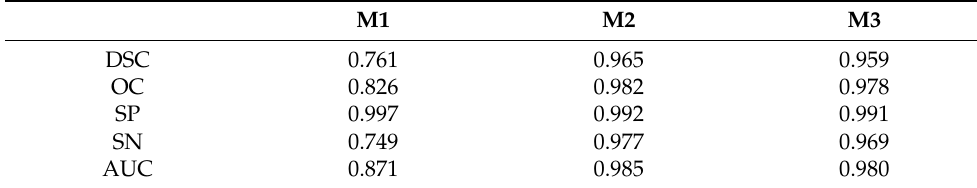
Table 2. Mean scores for models M1, M2 and M3 in the whole set of test images.